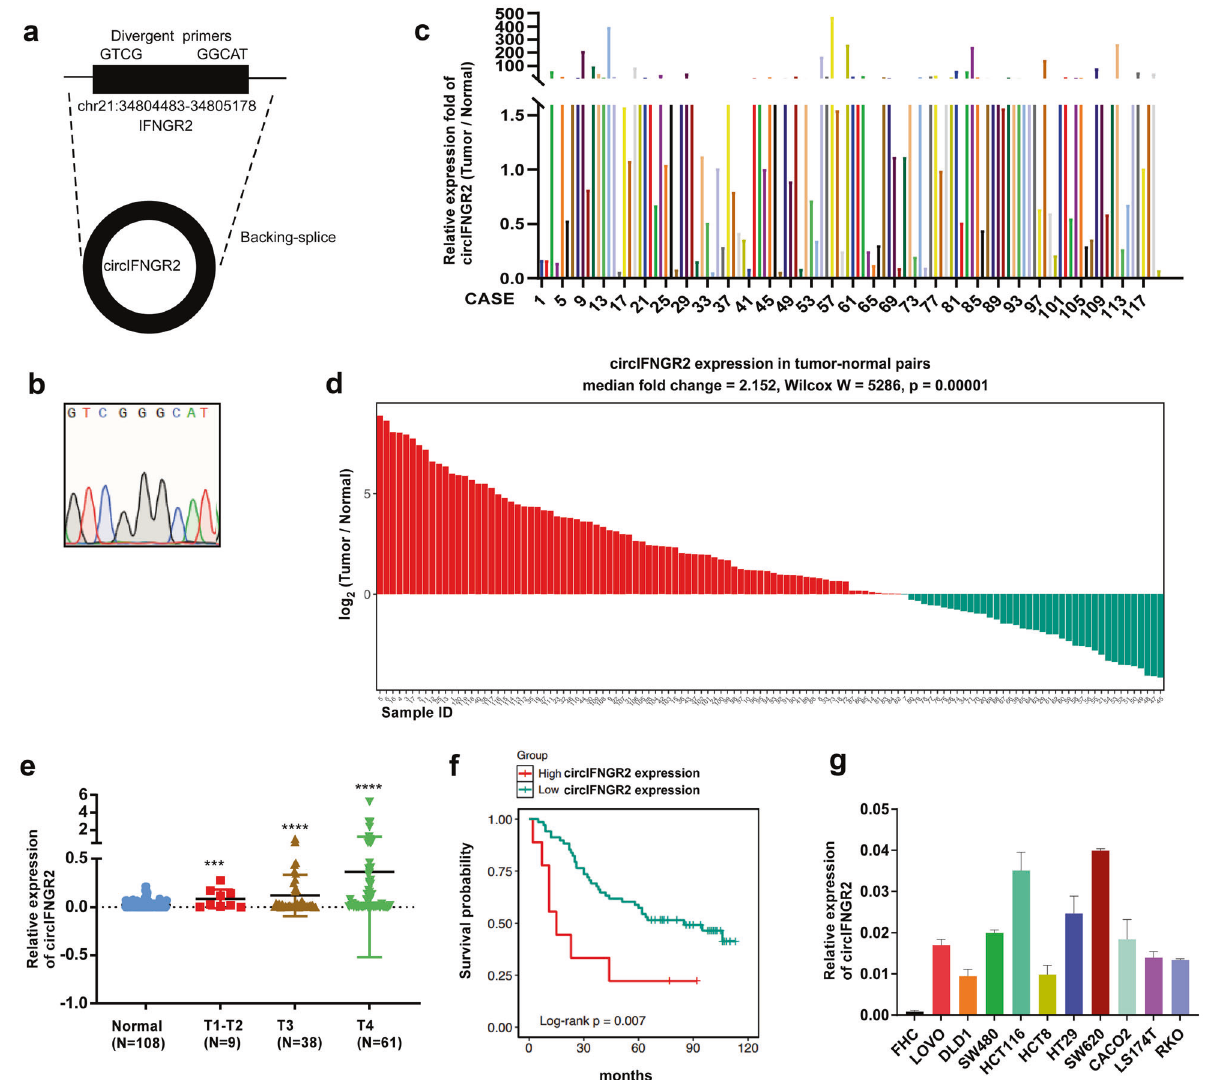
Fig. 1 circIFNGR2 is overexpressed in colorectal cancer. a circIFNGR2 is generated by splicing the INFGR2 gene, located on chromosome. b The back-splice junction sequences of circIFNGR2 shown by Sanger sequencing results. c RT-qPCR of circIFNGR2 in 120 paired human CRC tissues and the matched adjacent normal tissues. d The relative expression of circIFNGR2 in 120 normal and cancerous tissues was detected by Wilcoxon test. e The correlation between the expression of circIFNGR2 and clinical stage (* p < 0.05, ** p < 0.01). f Kaplan – Meier survival analysis of WT-KRAS CRC patients with low and high expression of circIFNGR2. g circIFNGR2 expression was determined using RT-qPCR analysis in 10 colorectal cancer cell lines and FHC cell